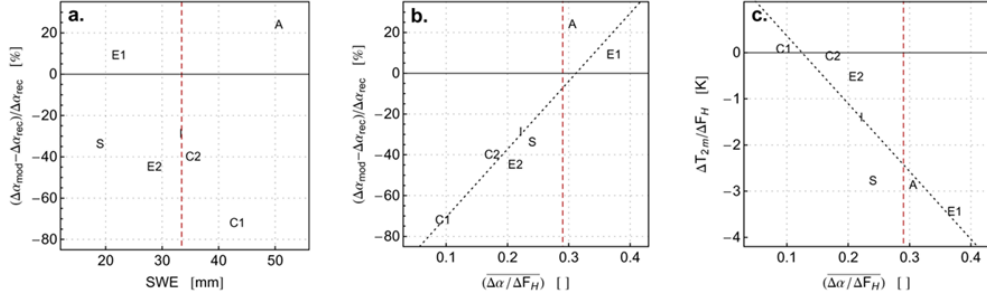
Fig. 9. Differences (relative, %) between the winter mean (DJF) reconstructed and simulated albedo responses to LCC in the region of study (box in Fig. 5), plotted against the simulated mean snow water equivalent (SWE) (a) , and plotted against the normalized albedo changes ( 1α/1F H ) averaged at different SWE levels (b) . Winter mean normalized 2-m temperature changes ( 1T 2m /1F H ) versus the mean 1α/1F H (c) . Dashed lines indicate the corresponding values obtained from the reference SWE dataset (NISDC) and the albedo reconstructions. Labels A, C1, C2, E1, E2, I and S indicate respectively ARPEGE, CCAM, CCSM, ECEARTH, ECHAM5, IPSL and